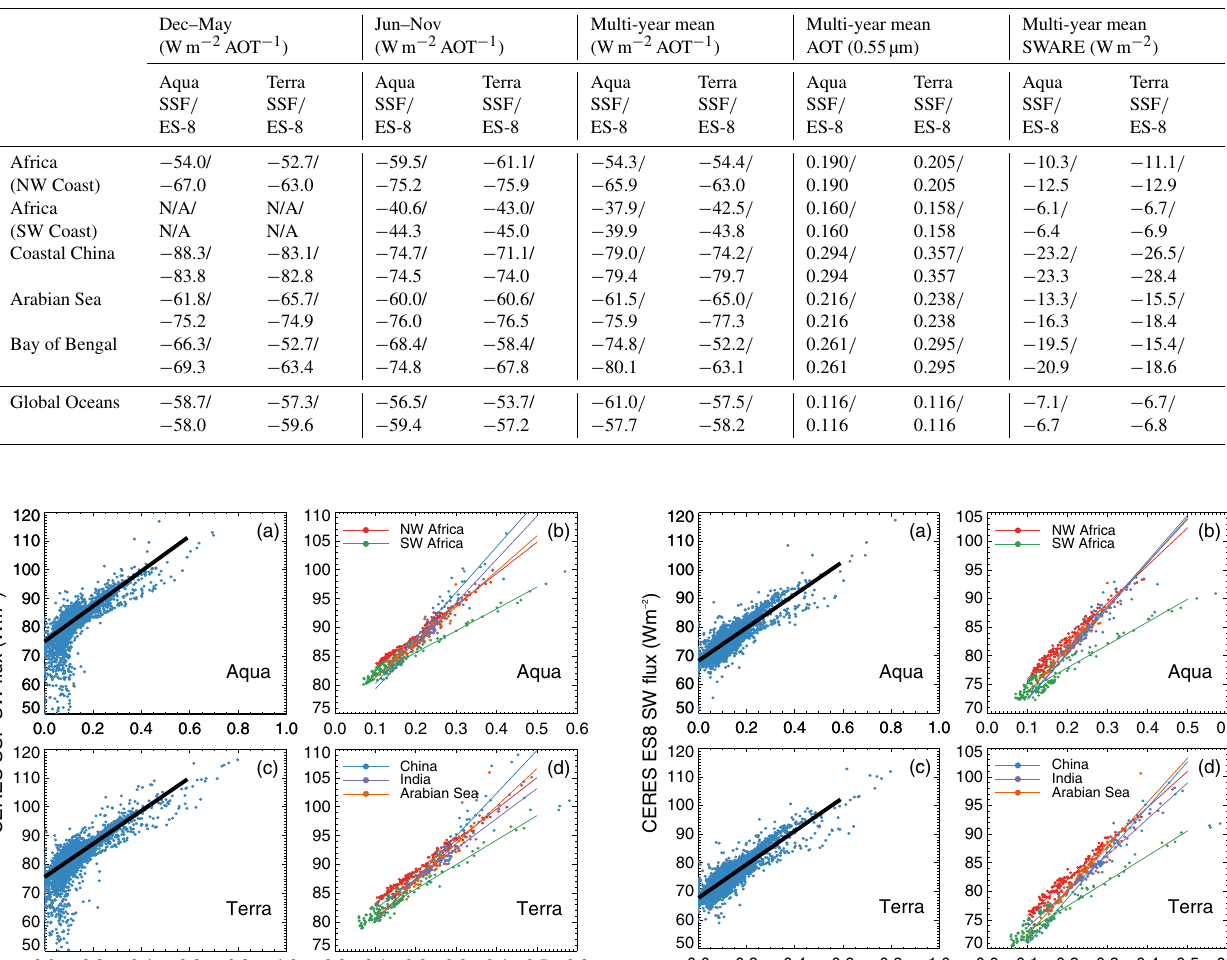
Table 4. Instantaneous SW aerosol direct forcing efficiencies estimated based on the multiyear means (2000–2015 for Terra and 2002–2015 for Aqua) as well as for December–May and June–November seasons using both CERES SSF and ES-8 datasets. Forcing efficiencies are calculated for selected regions that have the maximum 2 × 2 ◦ (latitude / longitude) bin-averaged AOT > 0 . 3, as well as for global oceans. The multiyear mean AOT and SWARE values are estimated using data from all valid bins. Note that values from this table are estimated under CERES cloud-free (less than 1% cloud fraction and larger than 99% CP) skies and thus regional and global AOT values may be different from the estimates as shown in Table 2.